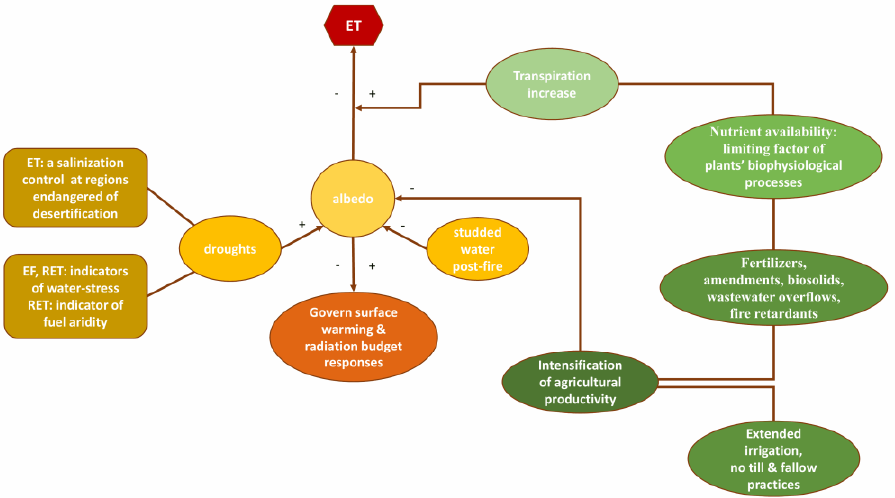
Figure 2. Contributions (positive (+) or negative ( − )) of key environmental drivers to the fluctuation of actual ET rate.